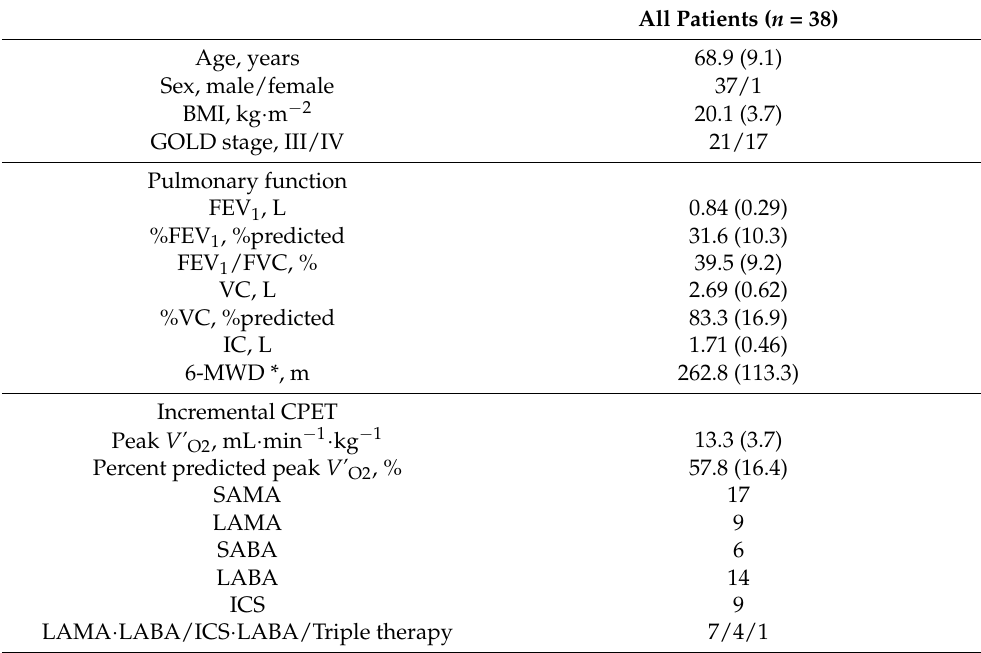
Table 1. Patient baseline characteristics ( n =